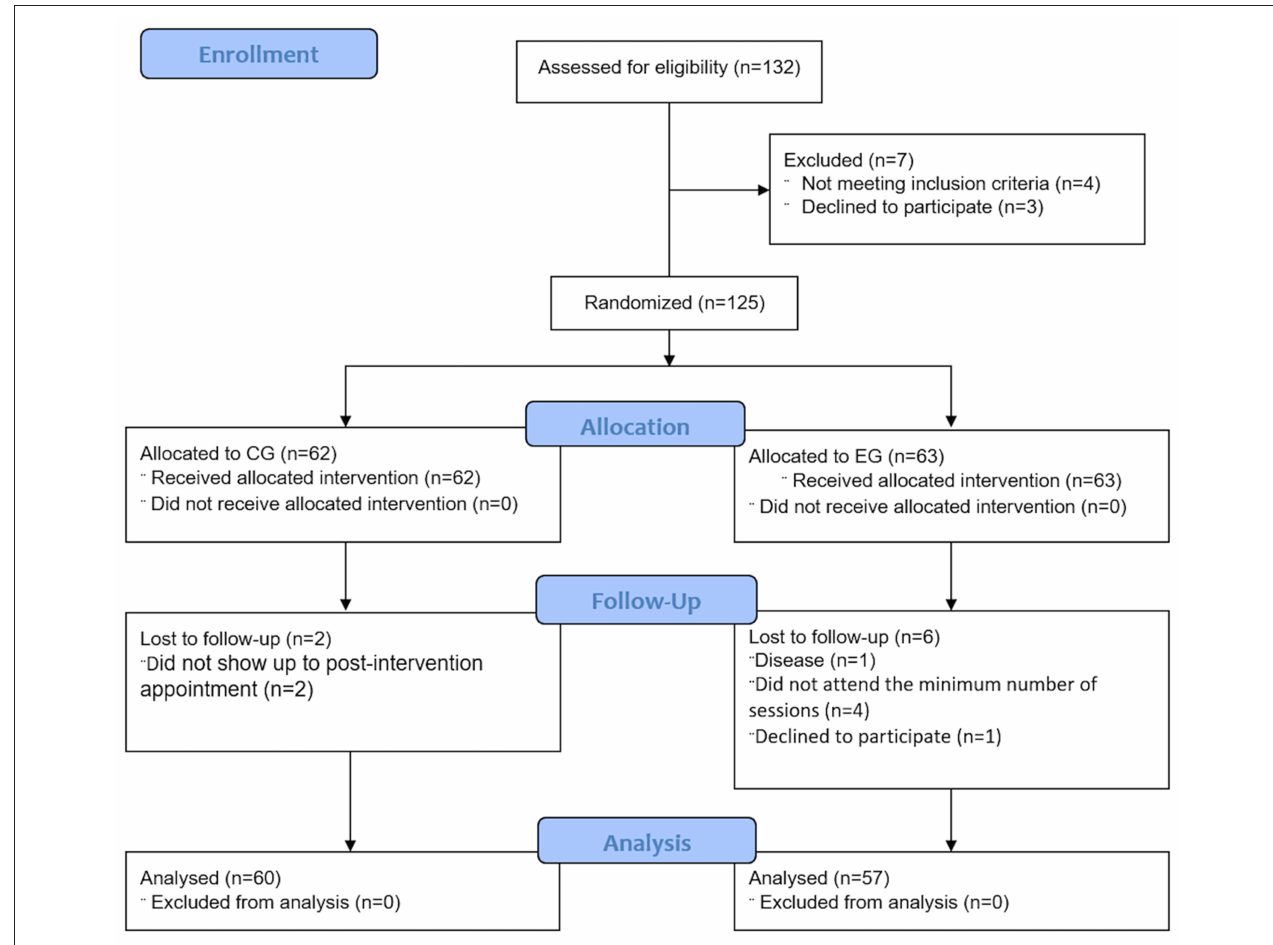
FIGURE 1 | Flow diagram of study